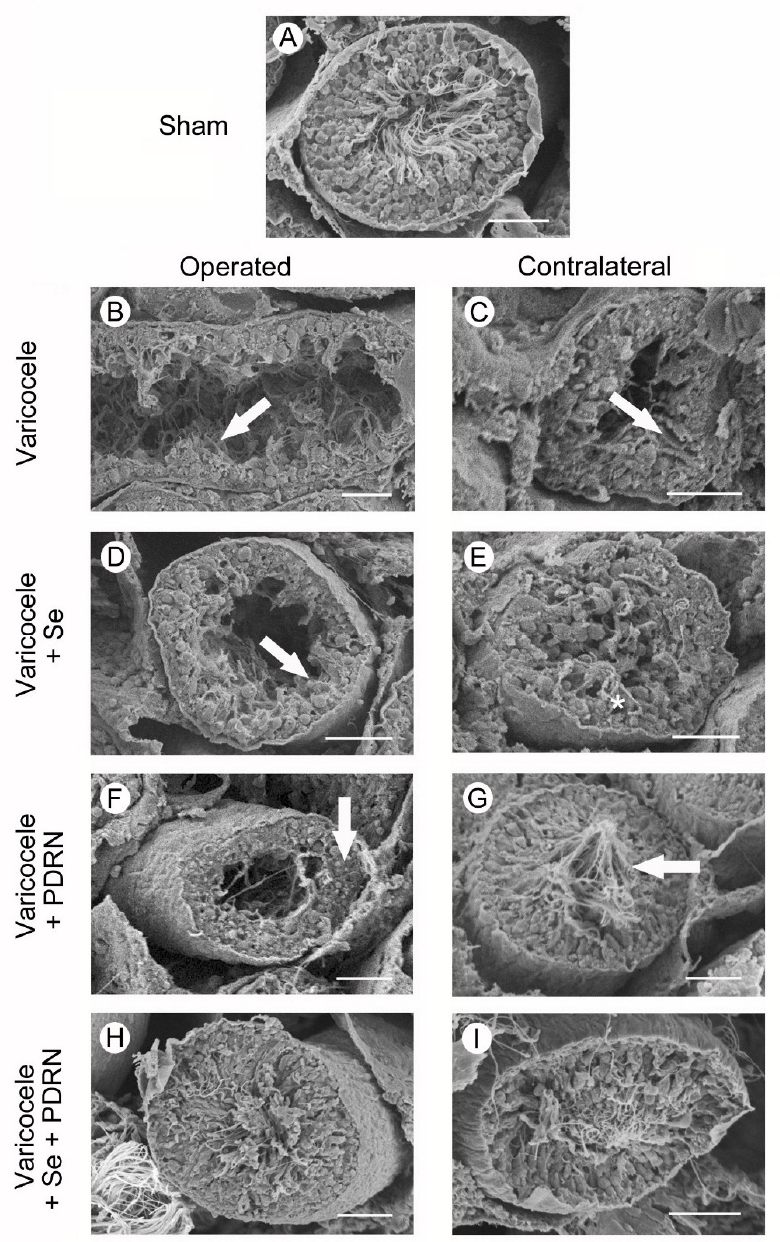
Figure 6. Scanning electron micrographs of testes from sham, varicocele, varicocele contralateral, varicocele plus Se (0.4 mg/kg/day i.p.), varicocele plus Se contralateral, varicocele plus PDRN (8 mg/kg/day i.p.), varicocele contralateral plus PDRN, varicocele plus Se plus PDRN, varicocele contralateral plus Se plus PDRN groups. ( A ): Sham animals. Note the normal structure of the seminiferous tubules. ( B ): Varicocele rats. Tubules show evident reduction in their height and condensed sperm tails (arrow). ( C ): In the contralateral testes of the same group, some clefts are present in the seminiferous epithelium (arrow). ( D ): In varicocele rats treated with Se, a low and irregularly arranged seminiferous epithelium is evident (arrow). ( E ): In the contralateral testes of the same group, only a few spermatozoa can be observed (asterisk). ( F ): In varicocele rats treated with PDRN the tubular lumen is reduced, owing to the presence of a higher epithelium (arrow). ( G ): In the contralateral testes of the same group, many spermatozoa are present (arrow). ( H , I ): In varicocele rats treated with Se plus PDRN, both the operated and the contralateral testes show close to normal organization. (Scale bar: 50 µm).